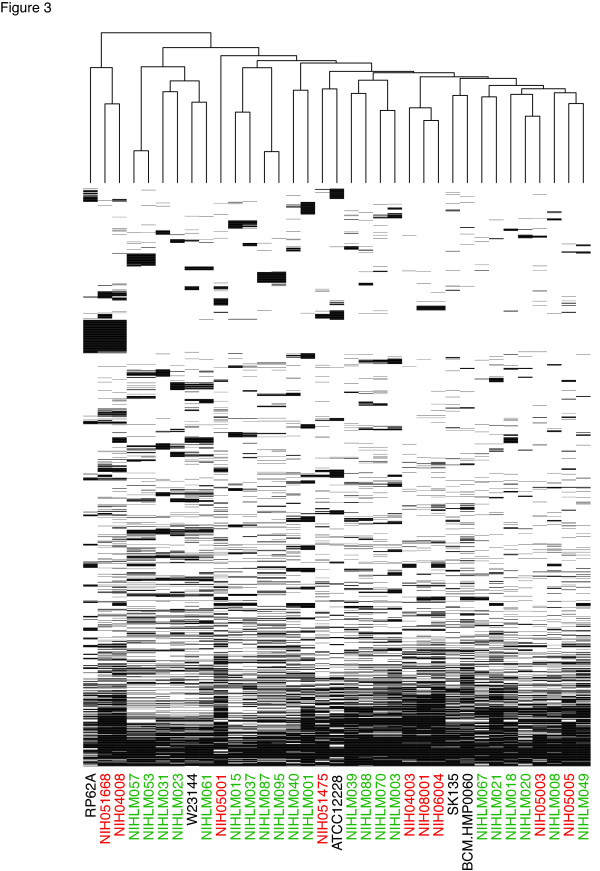
S. epidermidis variable genome is dominated by genes shared by few strains. Only the variable genome is shown. Gene clusters present in all genomes or present in only a single genome are omitted. The presence of a gene (and its paralogs) is indicated by a black bar. Nosocomial and commensal isolate names are colored red and green, respectively. The dendrogram was generated using complete linkage clustering of the presence/absence data.